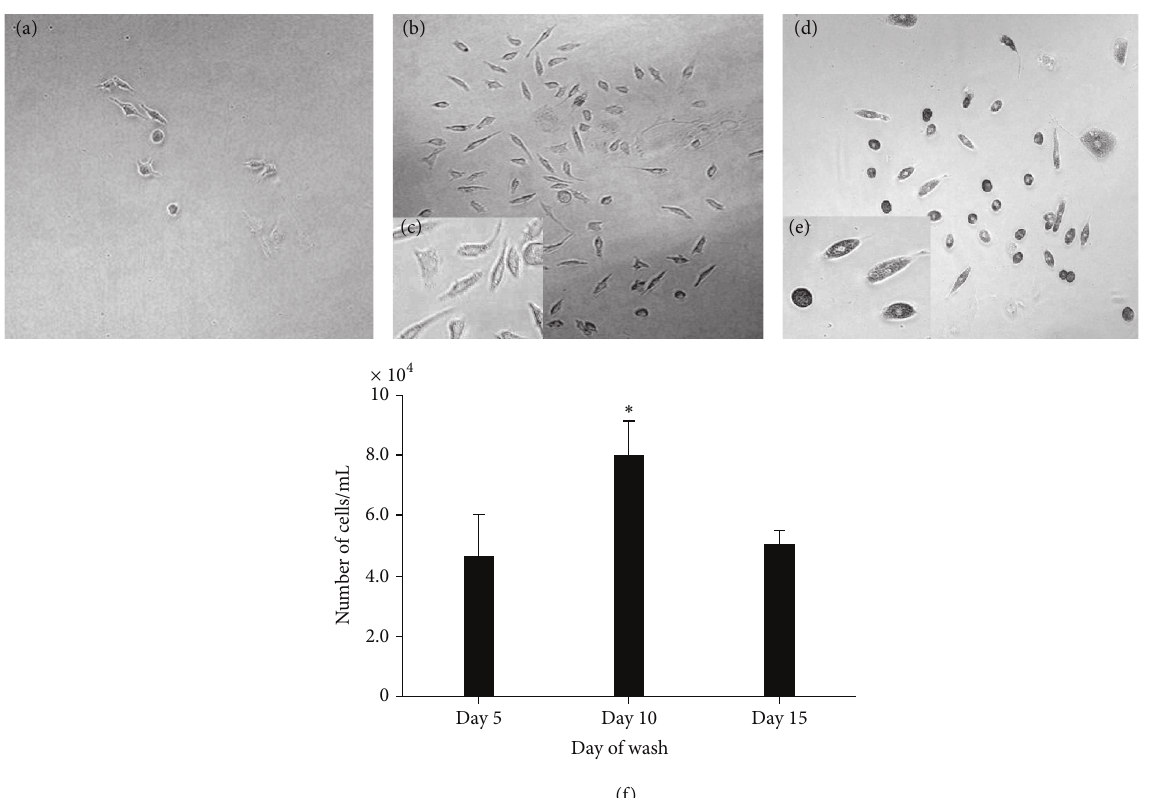
Figure 4: Microglial cells isolated from the mixed culture on different days influence the microglial cell numbers and morphology. (a) Removing nonadherent cells on day 5 yielded the least number of cells. ((b) and (c)) Microglial cultures on day 10. ((d) and (e)) Microglial cultures on day 15. Day 10 seems to be ideal time to wash away loosely adherent cells and dead cells. Day 15 seems to affect the morphology of the cell. Microglial cells were observed using a phase-contrast Olympus microscope and Prog Res C14 imaging software. Magnification ×